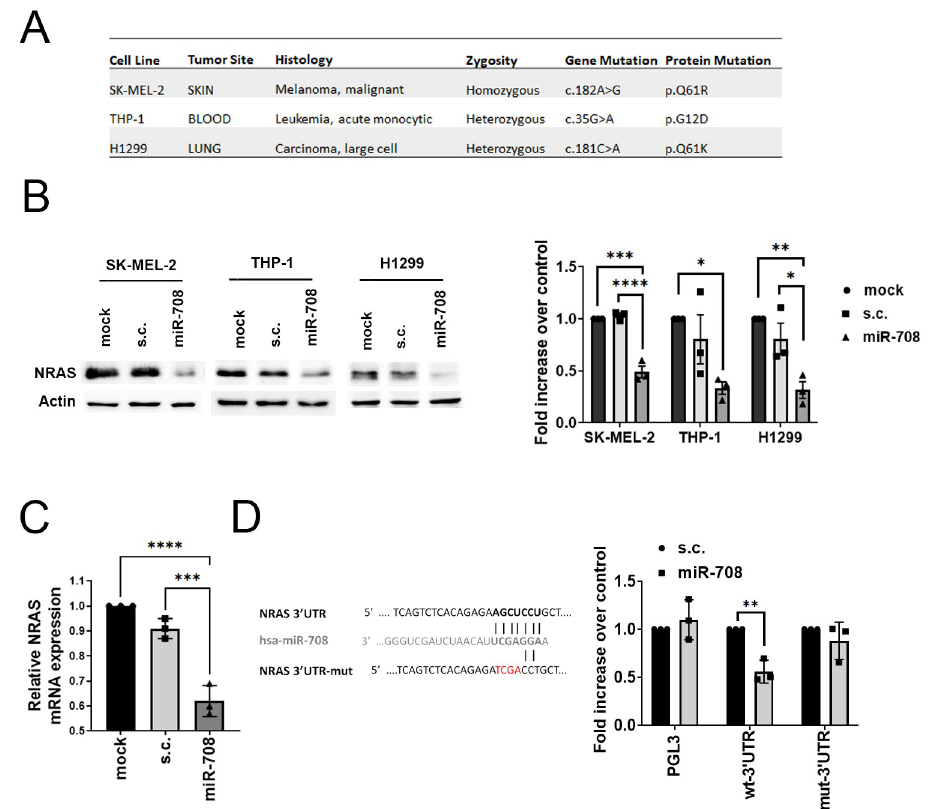
Fig 1. NRAS is the direct target of miR-708. (A) Cancer cell lines with NRAS mutation used in this study. (B) Left: Representative Western blot of NRAS protein expression in SK-MEL-2, THP-1, and H1299 cells transfected with mock, scrambled control (s.c.), and precursor miR-708 (pre-miR-708) for 48 h. Right: quantitative analysis of NRAS protein level, normalized with actin. Histogram represents normalized means ± SEM (n = 3 biological replicates). (C) Expression of NRAS mRNA in SK-MEL-2 cells transfected mock, s.c., and pre-miR-708. Data represent normalized means ± SD (n = 3 biological replicates). (D) Luciferase reporter assays showing luciferase activities in the pGL3 construct conjugated with NRAS 3’UTR (wild type or mutant form) by SK-MEL-2 transfected with pre-miR-708 or s.c. Left: the sequence of miR-708 and the potential miR-708 binding site on NRAS 3’UTR. Nucleotides mutated in miR- 708 binding sites are shown in red. Right: data represent normalized means ± SD (n = 3 biological replicates). One-way ANOVA followed by Tukey’s post-hoc test (B and C) and student’s t-test (two-tailed) (D) were used for the statistical test ( * p < 0.05, ** p < 0.01, *** p < 0.001, **** p < 0.0001).